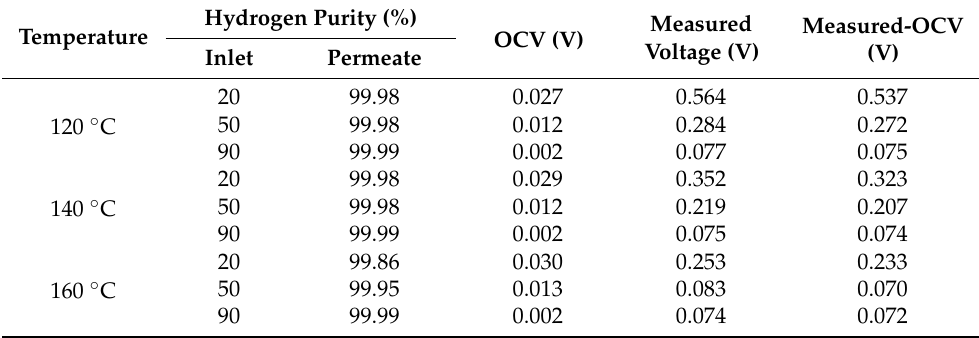
Table 3. Hydrogen purity and cell voltage values as a function of temperature for the H 2 /CH 4 feed mixtures, measured at 0.1 A cm − 2